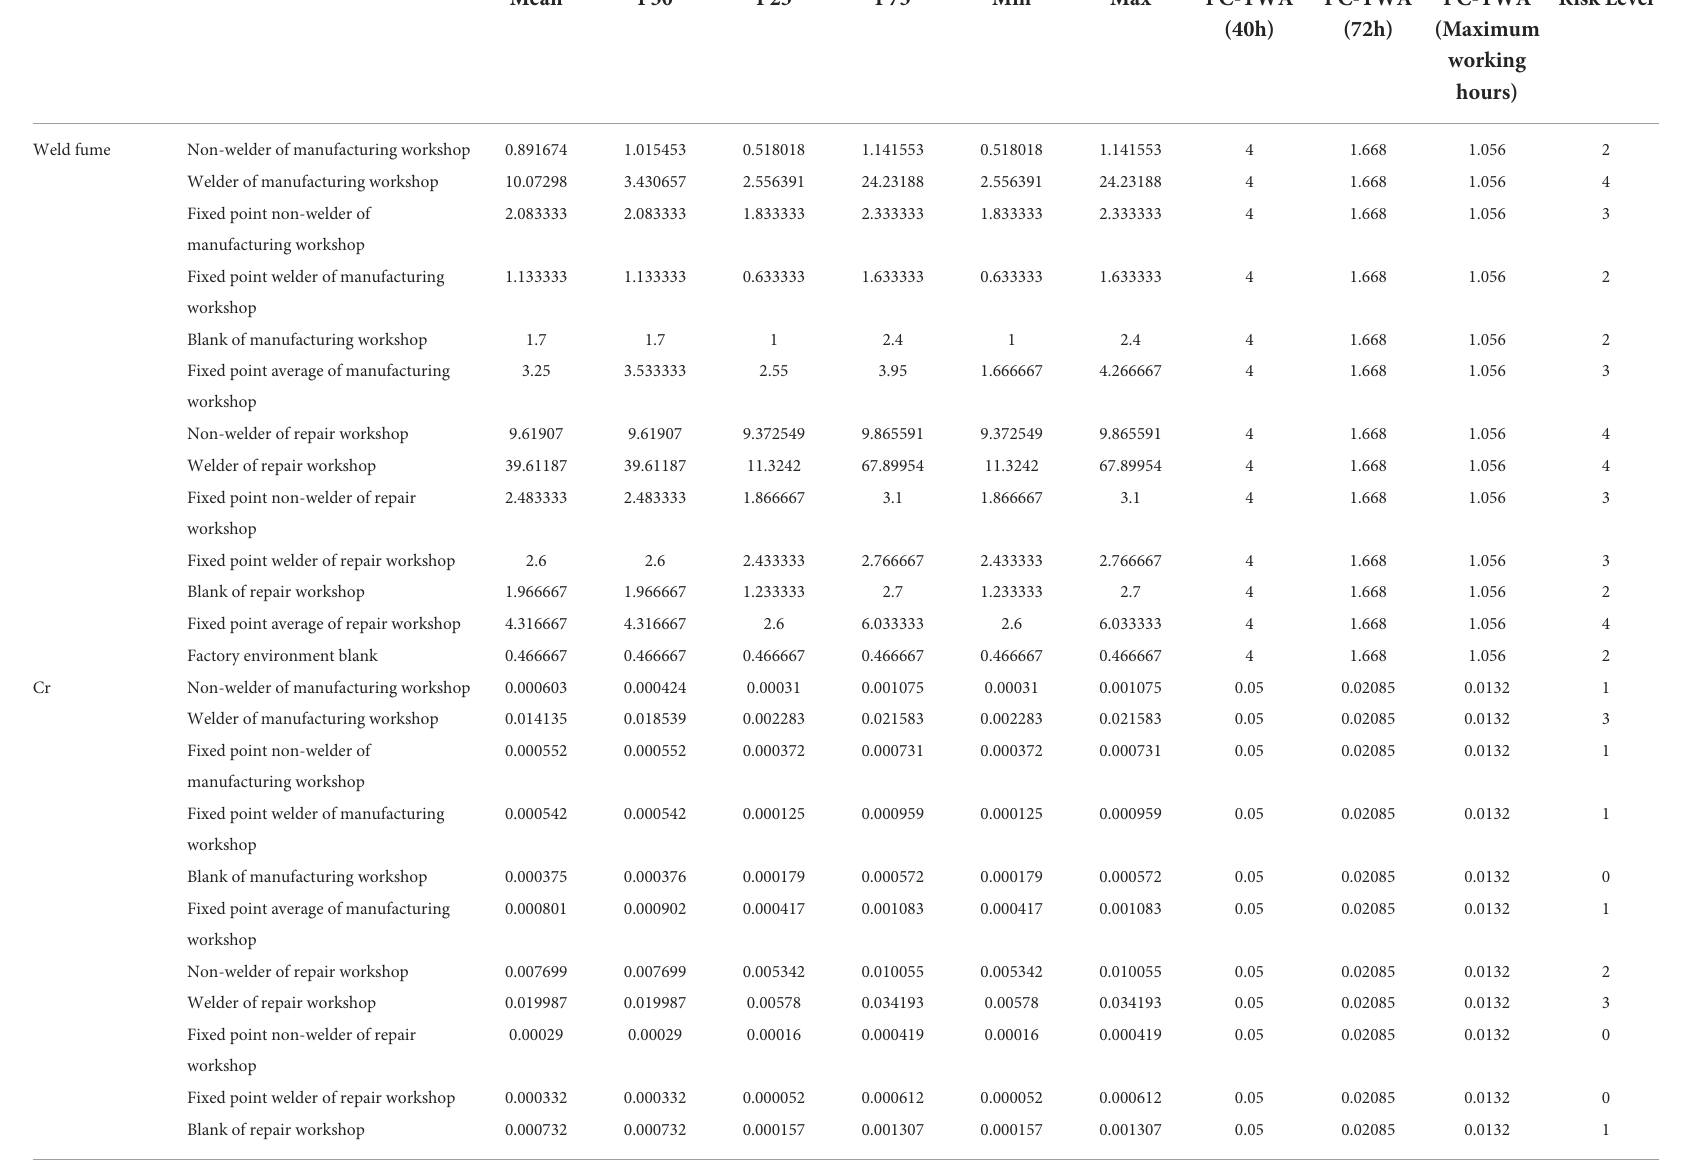
TABLE 1 Concentration and contact grade of welding fume and metal ions in